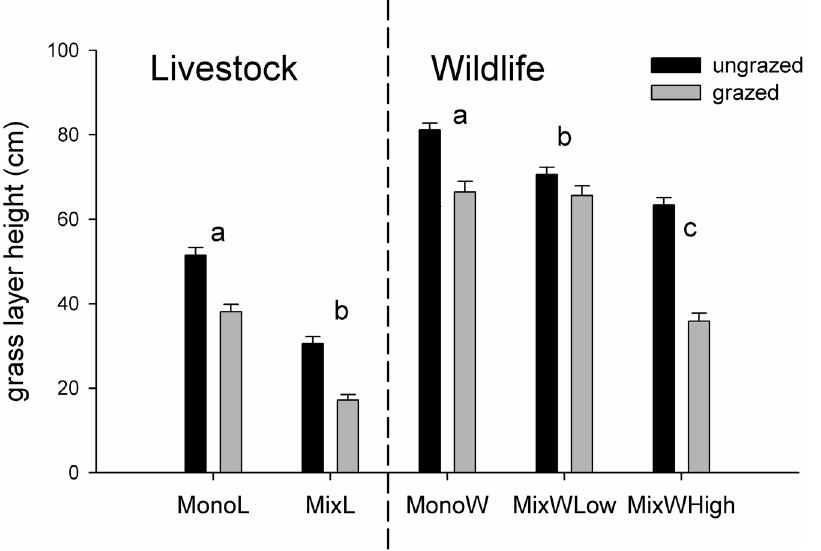
Figure 4. Average ( ± SE) grass height of ungrazed and grazed sites for different site types (see Table 1 for abbreviations). Different letters denote significant differences of the mean